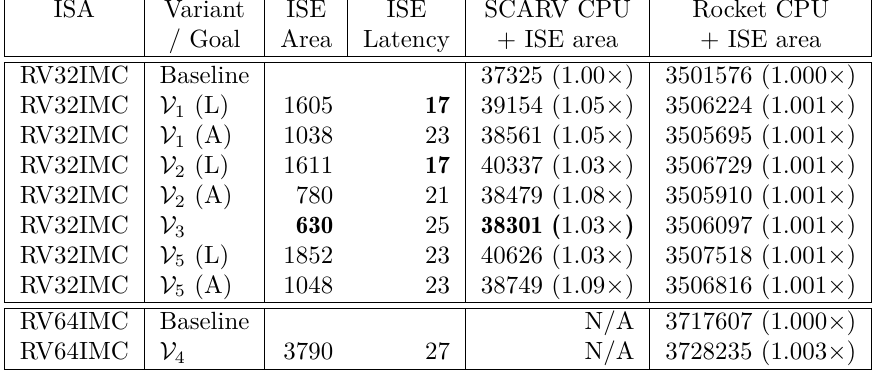
Table 8: Hardware implementation metrics for each ISE variant with only encrypt instructions implemented. Area is measured in NAND2 gate equivalents and latency in gate